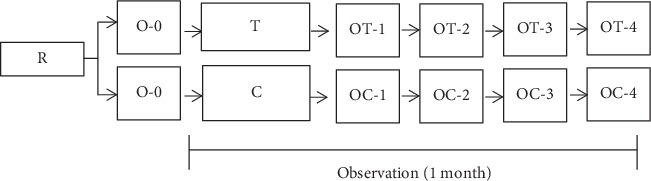
The study design. Description: R: randomization; O-0: observation at week 0; T: treatment group; C: control group; OT-1–4: observational treatment group at weeks 1–4; OC-1–4: observational control group at weeks 1–4.